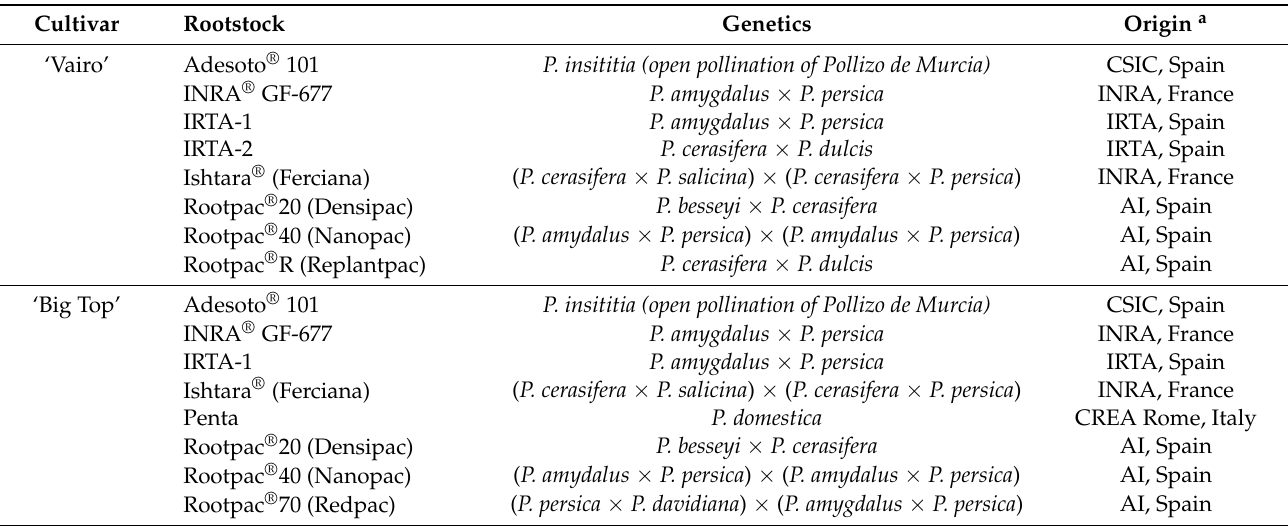
Table 1. List of the rootstocks evaluated for ‘Vairo’ almond and ‘Big Top’ nectarine cultivars, their genetics, and their